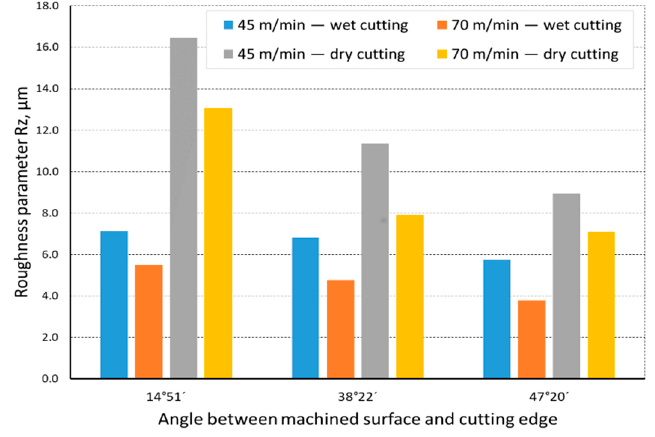
Figure 9. The impact of cutting speed on the variability of roughness parameter Rz in the function of the angle between the machined surface and cutting edge for a curvilinear track and a material hardness of 23 HRC.